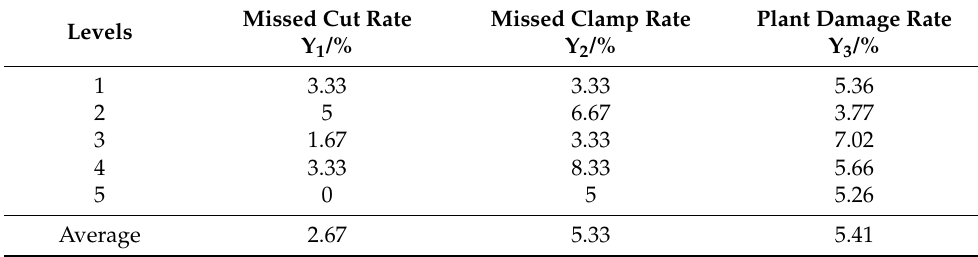
Table 7. Optimization parameter test